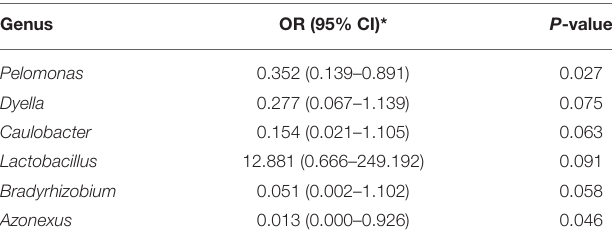
TABLE 2 | Predictive factors for IPF diagnosis assessed by multivariable logistic regression. Genus